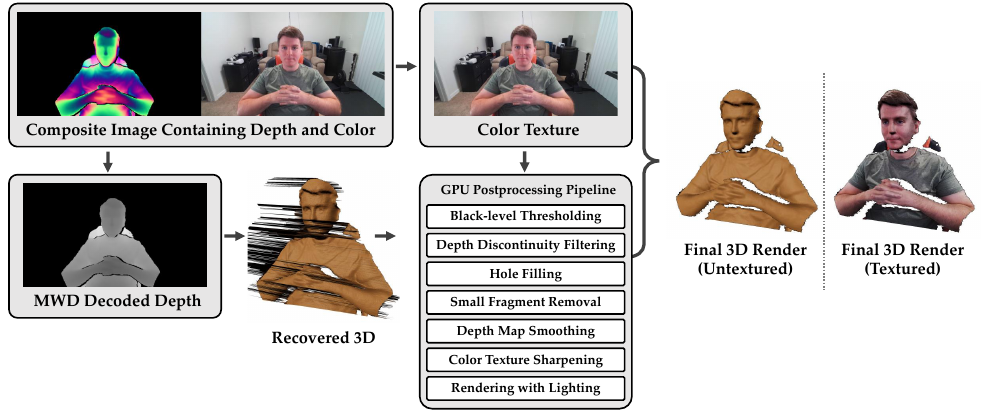
Figure 3. HoloKinect decoding and postprocessing pipeline. Due to the software settings we have elected to focus on in this work, Agora receives and decodes a 2560 × 720 RGB composite frame containing MWD-encoded depth and color texture information. The MWD data is decoded on a GPU-accelerated Unity compute shader using Equations (5)–(9). Decoded depth values outside of [ Z min , Z max ] are filtered out, as are pixels with brightness less than a black-level threshold. Also available within the GPU-accelerated compute shader are additional postprocessing steps,